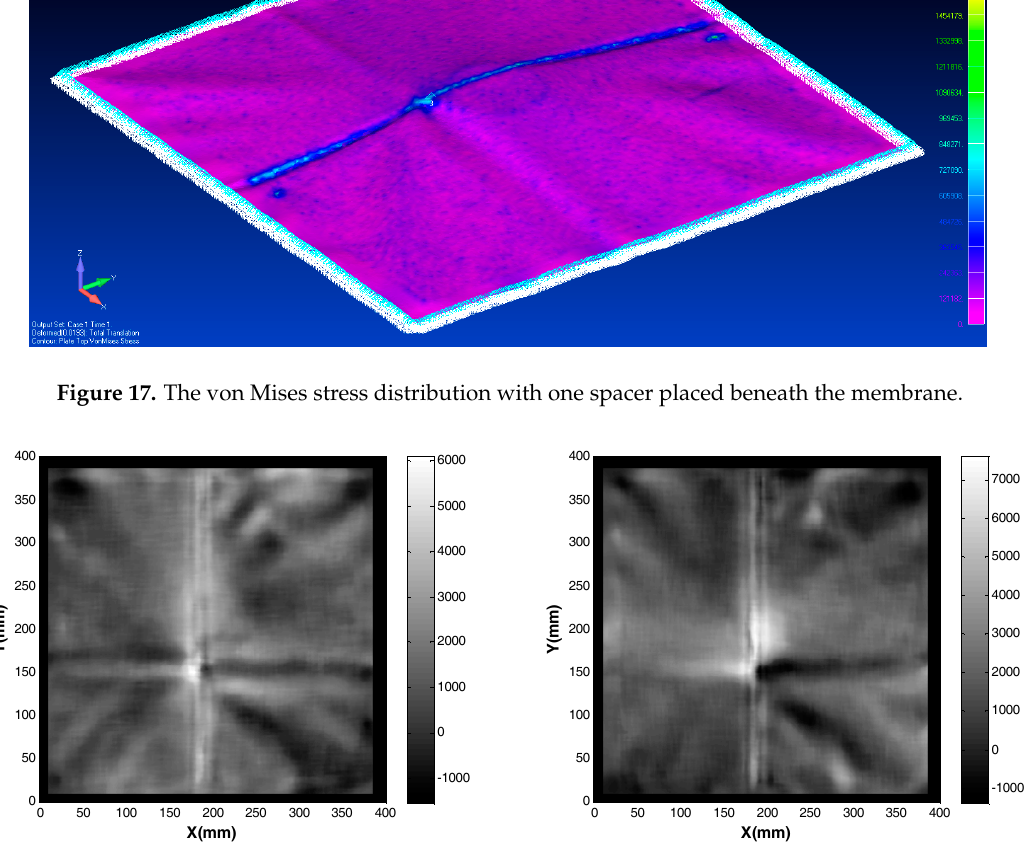
X(mm) X strain Y strain X(mm) Figure 18. Strain field obtained when membrane was loaded with one spacer added beneath the X strain Y strain X(mm) membrane. X strain Y strain Figure 18. Strain field obtained when membrane was loaded with one spacer added beneath the membrane. Figure 18. Strain field obtained when membrane was loaded with one spacer added beneath the Figure 18. Strain field obtained when membrane was loaded with one spacer added beneath membrane. the